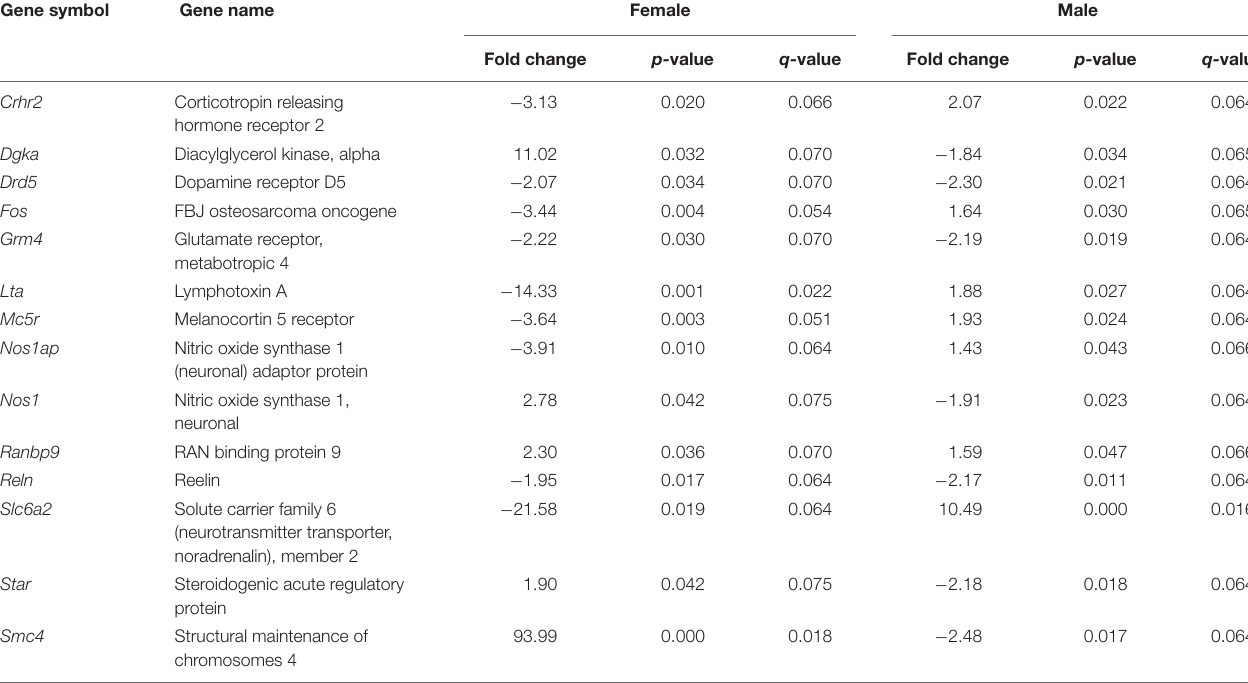
TABLE 2 | Nucleus accumbens genes significantly regulated by binge ethanol drinking in both female and male